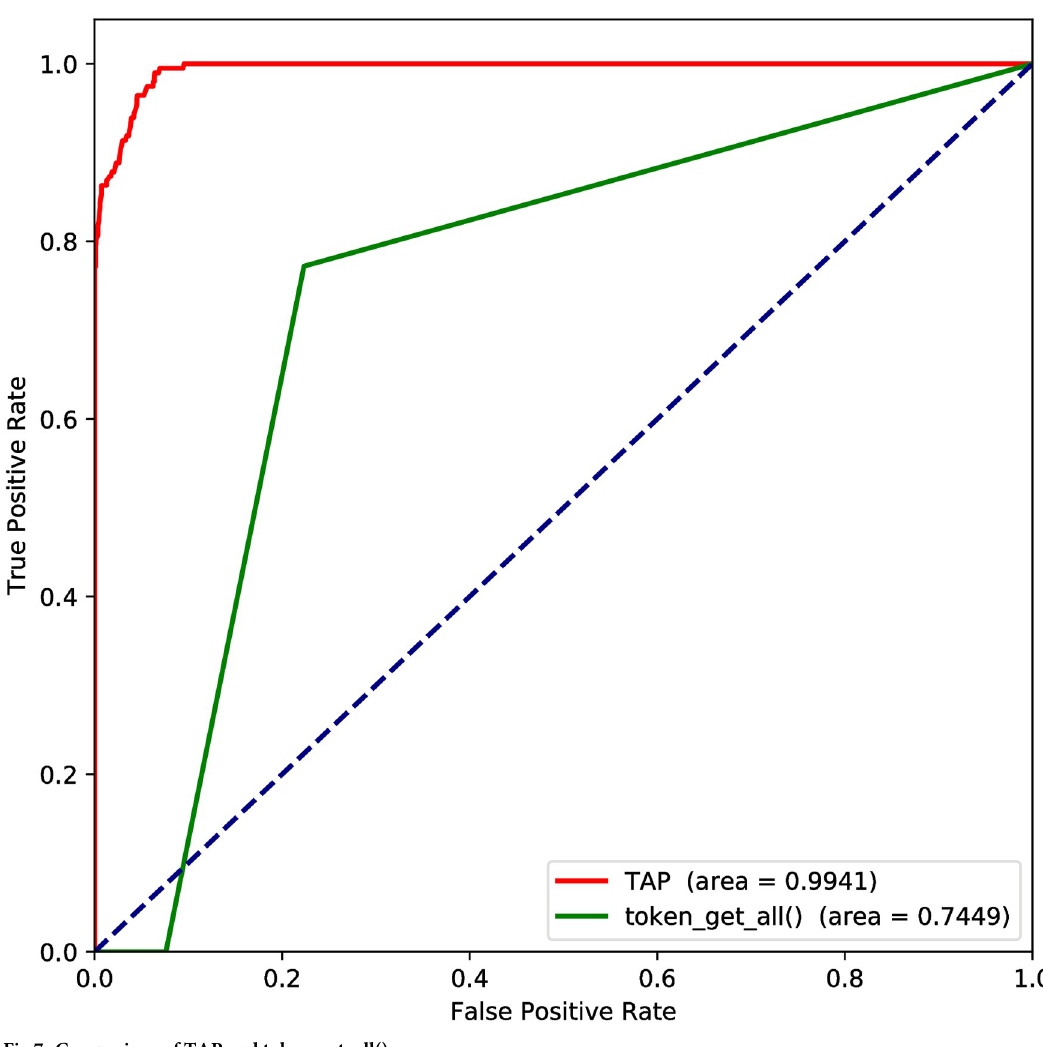
Fig 7. Comparison of TAP and token_get_all().